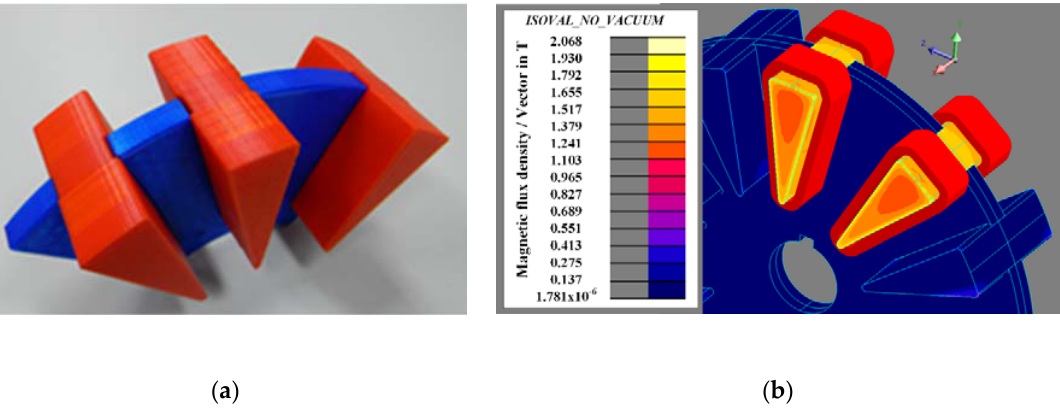
Figure 11. ( a ) Stator pole arrangement into the structural disk with parts made by 3 D printing and ( b ) map of magnetic flux density in the stator poles obtained by 3D ‐ FEA when there is full alignment ( b ) map of magnetic flux density in the stator poles obtained by 3D-FEA when there is full alignment with the rotor poles for a current of 100 A. with the rotor poles for a current of 100